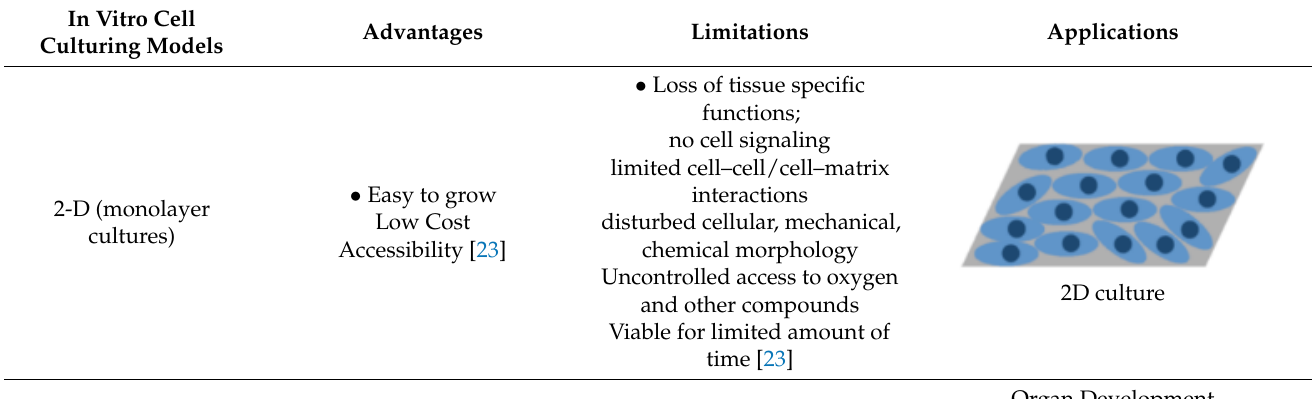
Table 1. Cell culture methods.